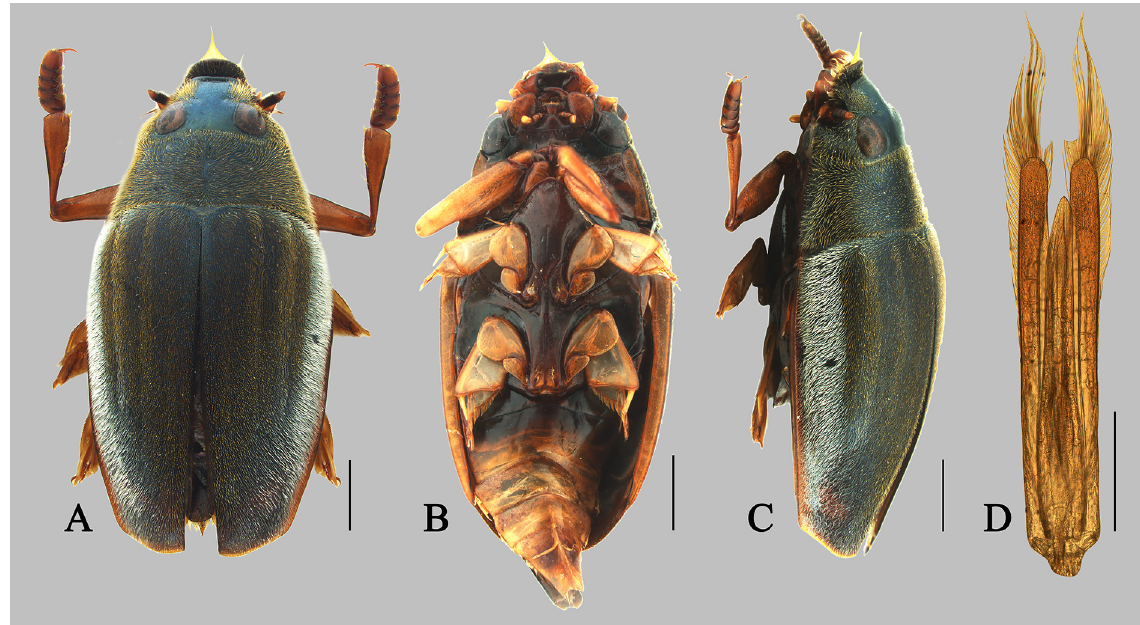
Fig. 8. Orectochilus argenteolimbatus Peschet, 1923, ♂ (SYSU). A . Habitus, dorsal view. B . Habitus, ventral view. C . Habitus, lateral view. D . Male genitalia. Scale bars: A–C = 1 mm; D = 0.5